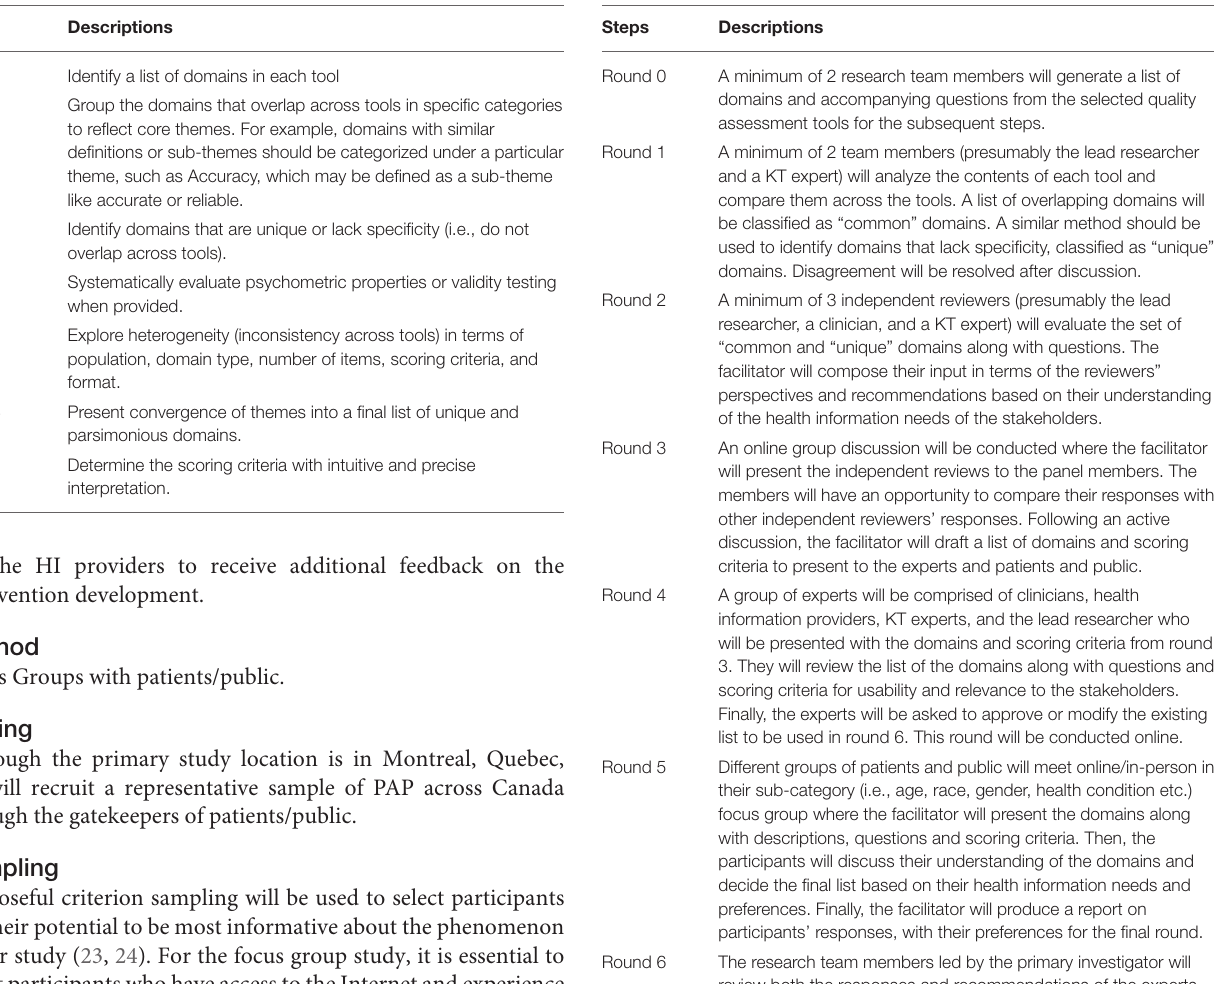
TABLE 1 | Conceptual framework for analyzing contents. TABLE 2 | Guideline for delphi